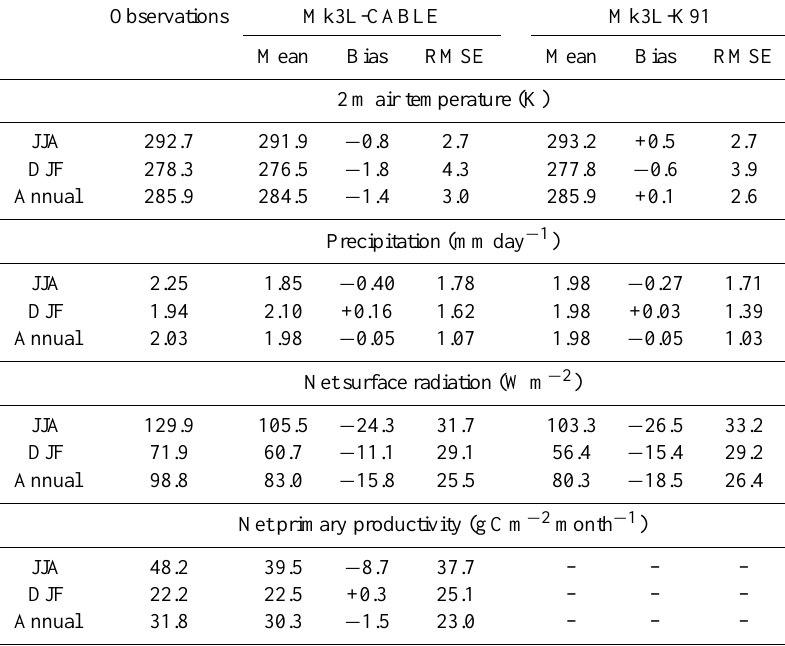
Table 3. The June-July-August (JJA), December-January-February (DJF) and annual means, biases and root-mean-square errors (RMSE) for selected variables over the global land surface, excluding Antarctica. The observational data is the same as that shown in Figs. 3, 4, 5 and 9, and is remapped to the Mk3L grid using bilinear interpolation prior to the bias and RMSE calculations. Net primary productivity is not calculated by